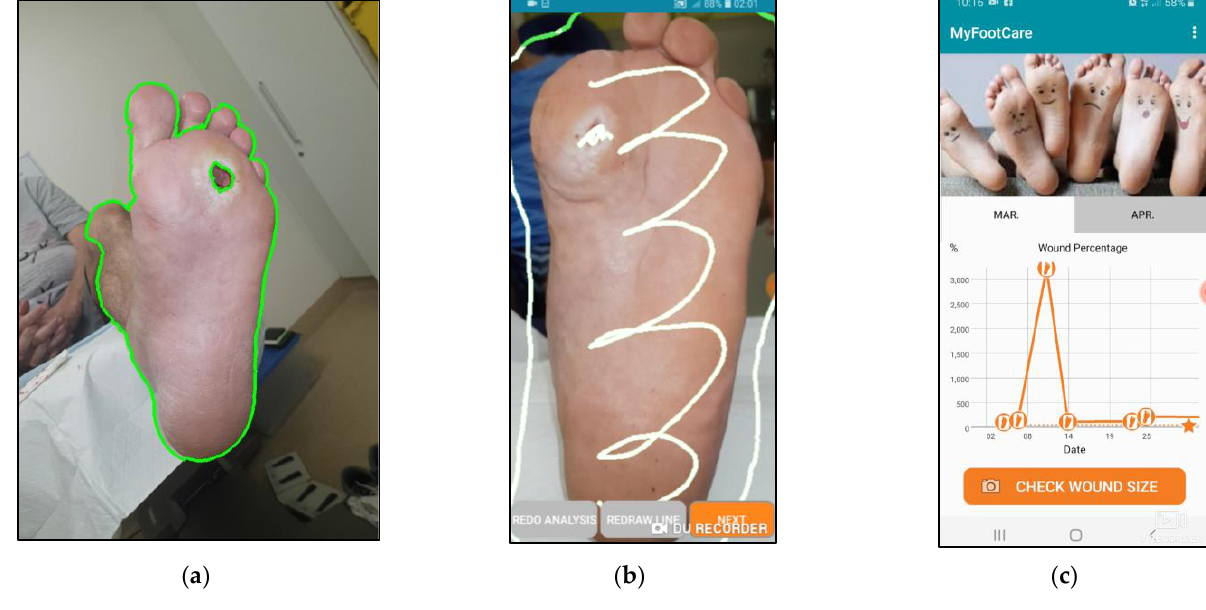
Figure 5. Examples of problems. ( a ) Background distractions such as skin of the leg and arm led to poor analysis results, with the green outline of the foot also covering the leg (P01F). ( b ) The white lines show the lines drawn by P12F during the analysis. The scribble drawn to indicate the ulcer cuts across the edge of the ulcer, and therefore, the analysis did not work. ( c ) Outliers in the data that were due to analysis problems changed the scale of the graph and made the progress difficult to see.